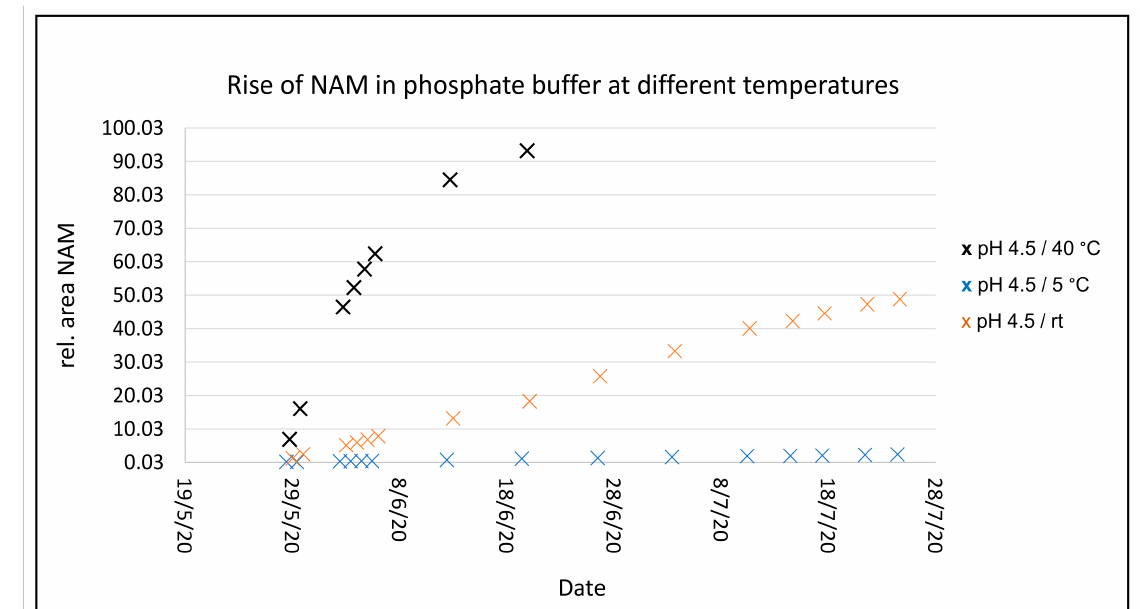
Figure 5. Degradation rate of NR + L -hydrogen malate to NAM as peak area measurement over time at pH 4.5 at differ- ent